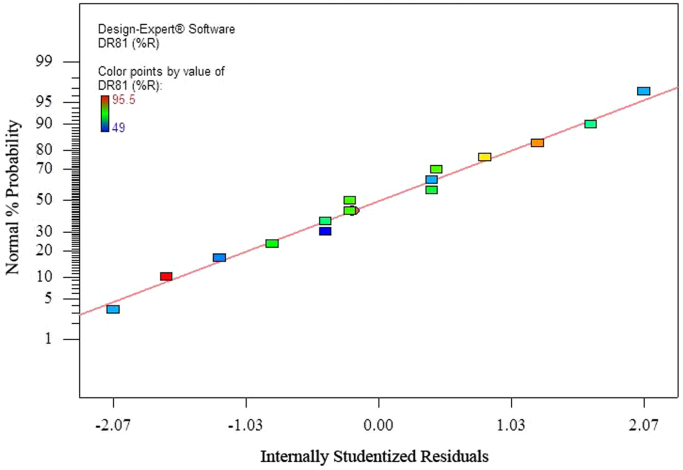
Normal probability plots of internally studentized residuals for DR81 elimination.